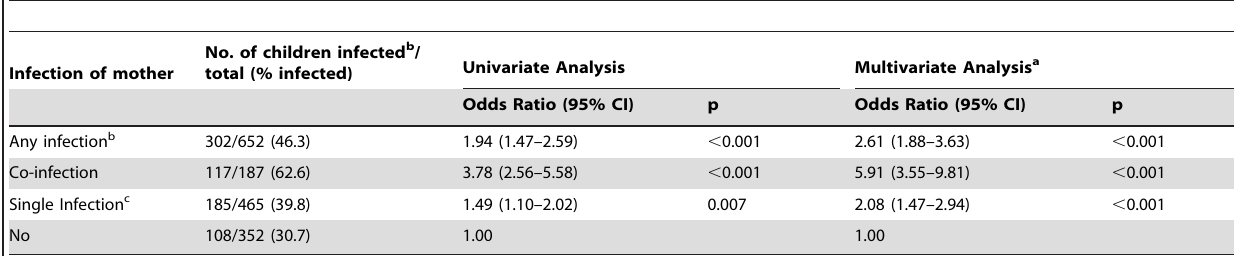
Table 2. Effects of any, both, or single maternal infection with A. lumbricoides and T. trichiura on childhood susceptibility to any STH infection.